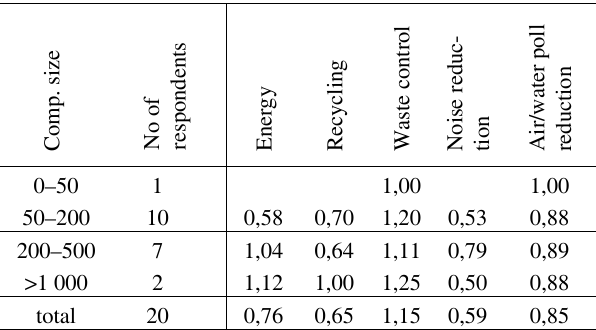
Table 7. Importance of environmental issues with respect to the company size